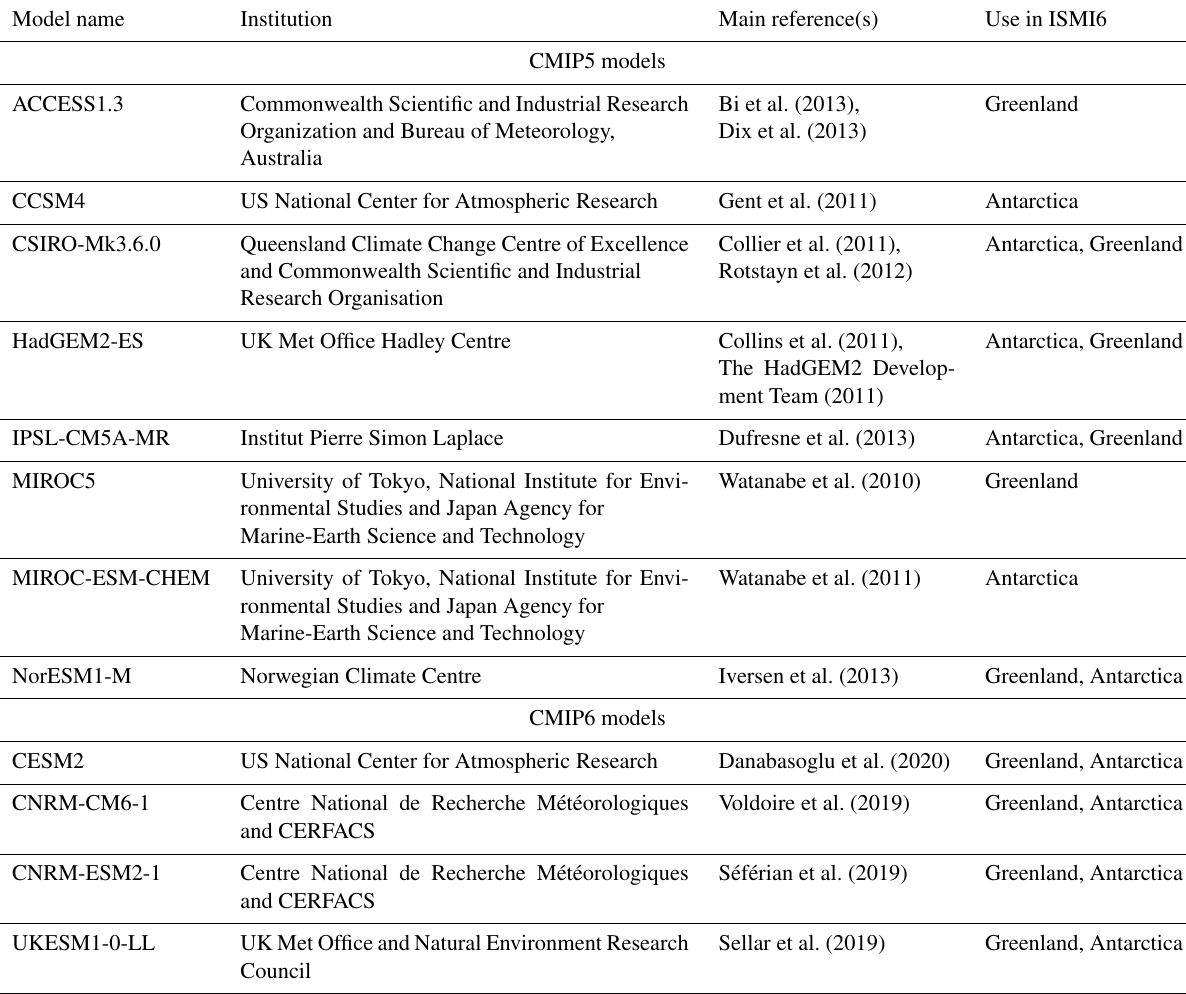
Table 1. CMIP model used to obtain atmospheric and oceanic forcing for the Greenland and Antarctic ice sheets. Model name